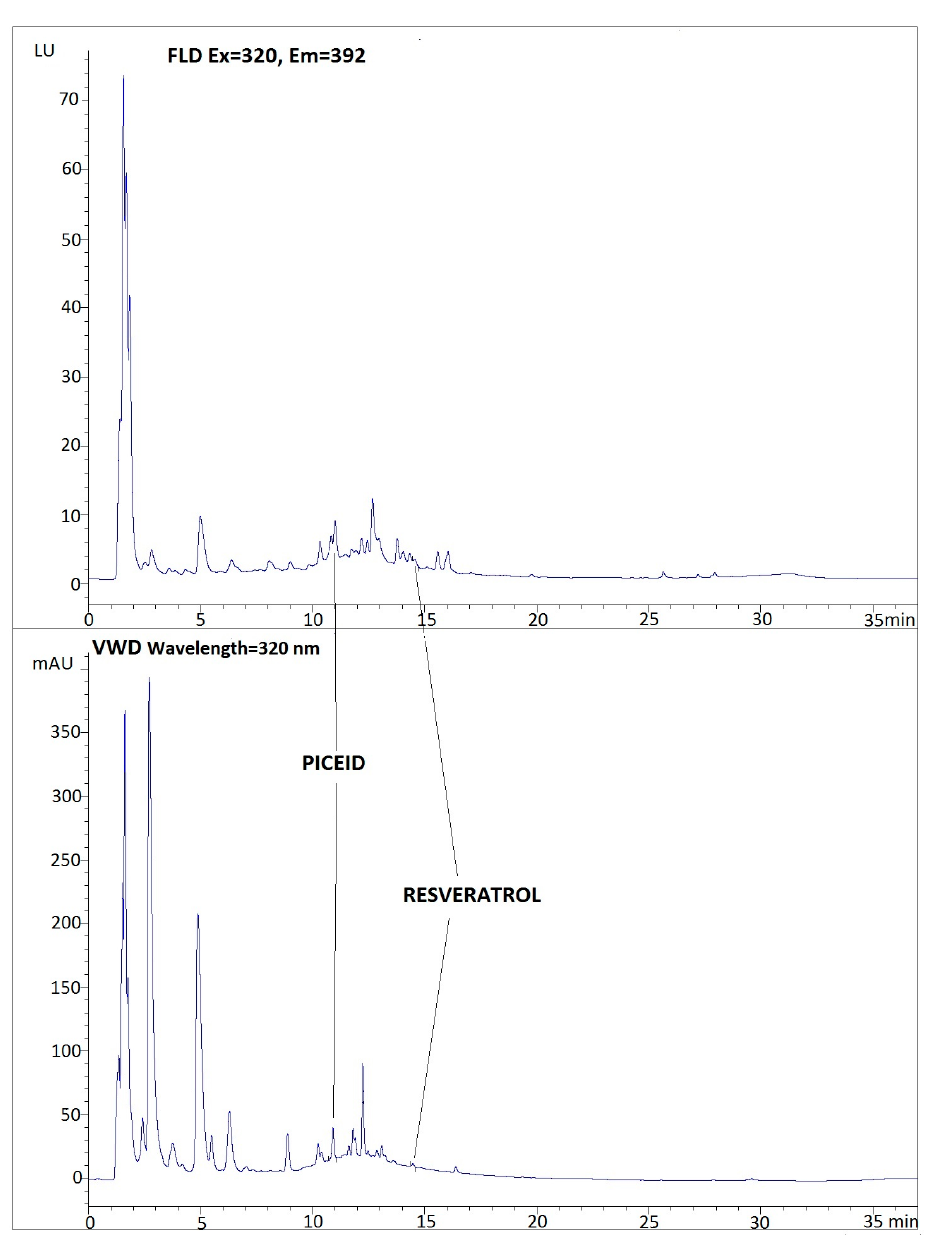
Figure 1. Chromatogram of a commercial fruit juice (Sample 5).